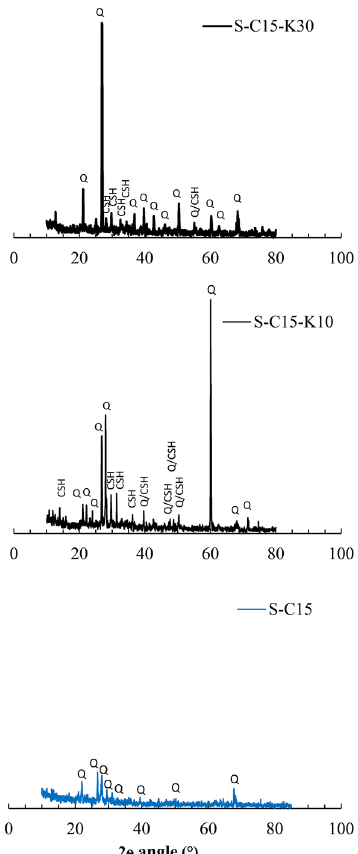
Fig. 24 The XRD graph of mixtures with 15% cement and enriched with kaolinite additive (Q: quartz, CSH: calcium silicate hydration, M: